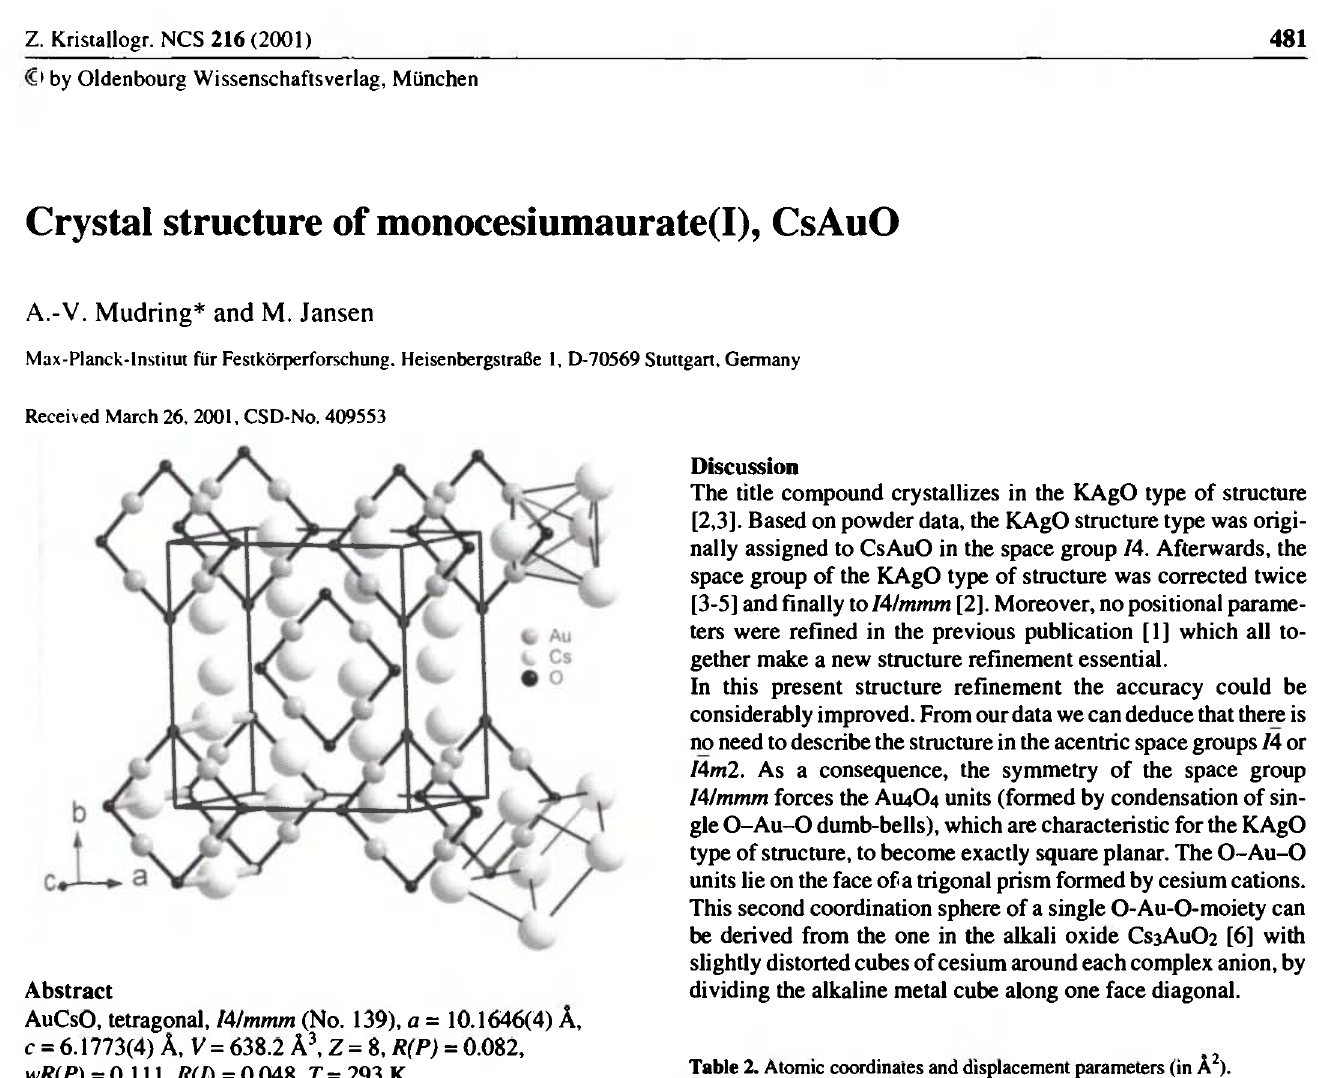
Table 1. Data collection and handling.